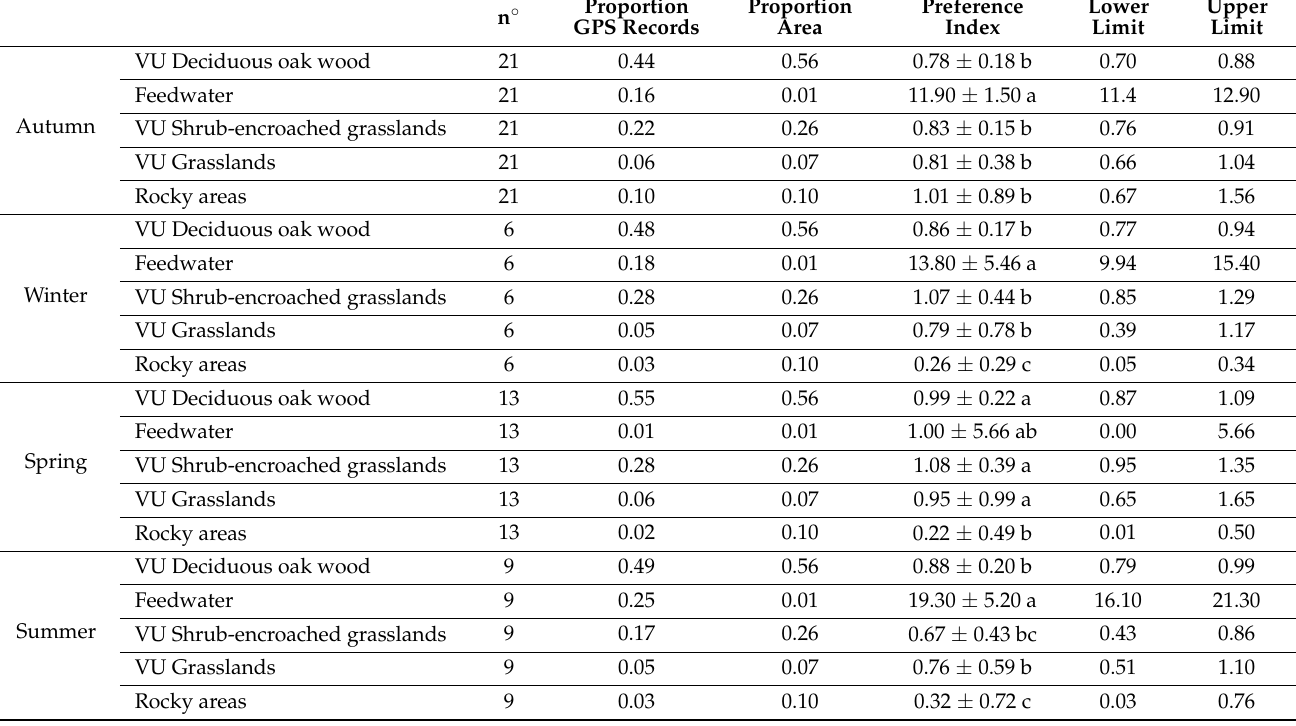
Table 4. Proportion of GPS records and preference index (PI) (with a 95% confidence interval) for three structural physiognomic units of vegetation (VU), rocky areas and feedwater areas in the different seasons of grazing cattle under continuous grazing system in a Mediterranean silvopastoral area (median ± interquartile range). n